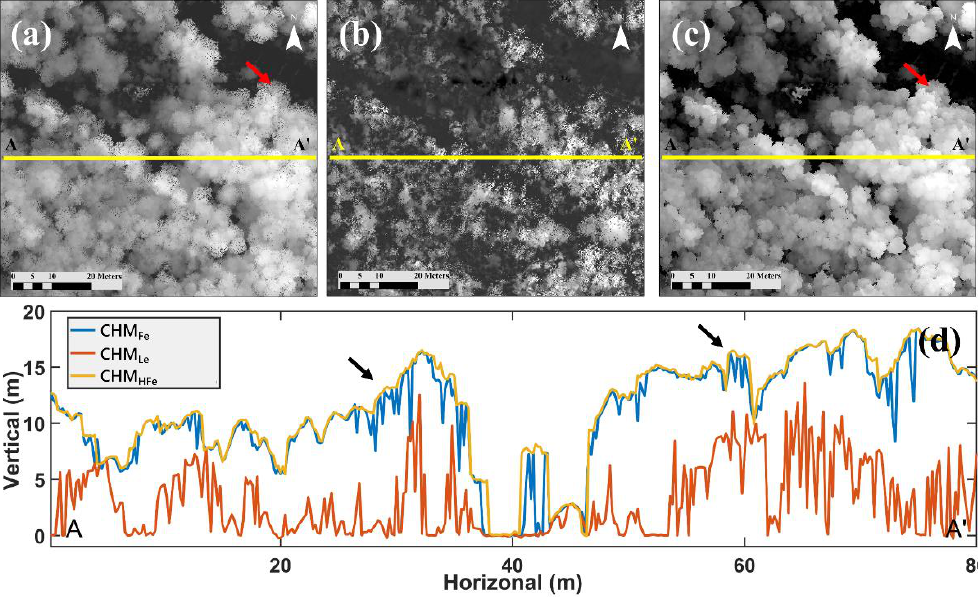
Figure 3. Comparing features of three types of CHM data (Csize = 0.2 m). The range of ( a – c ) is marked in Figure 1a with a yellow dotted line. ( a ) CHM Fe ; ( b ) CHM Le ; ( c ) CHM HFe ; ( d ) Sectional views of three types of CHM data, marked by a yellow line from A to A’ in (a–c).